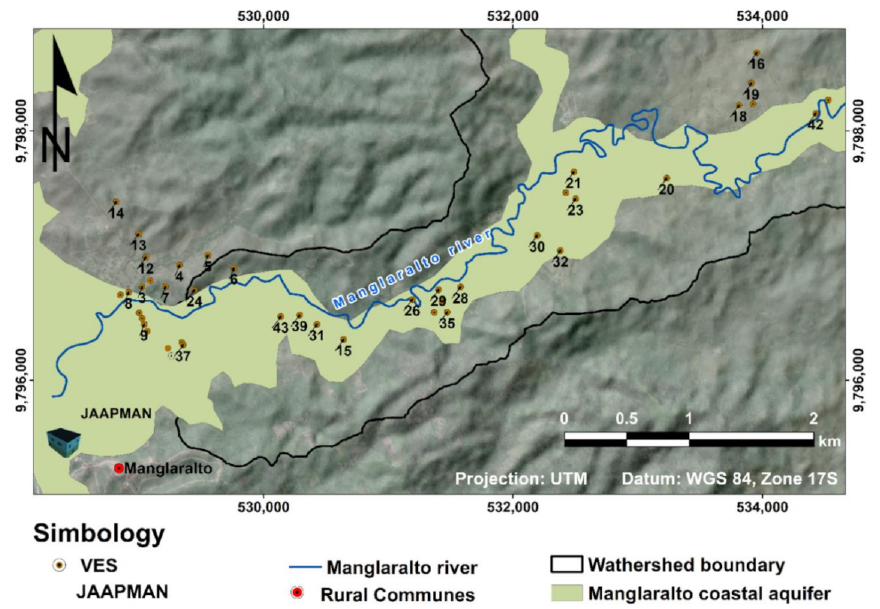
Figure 3. Locations of Vertical Electrical Soundings (VES) in the Manglaralto basin.